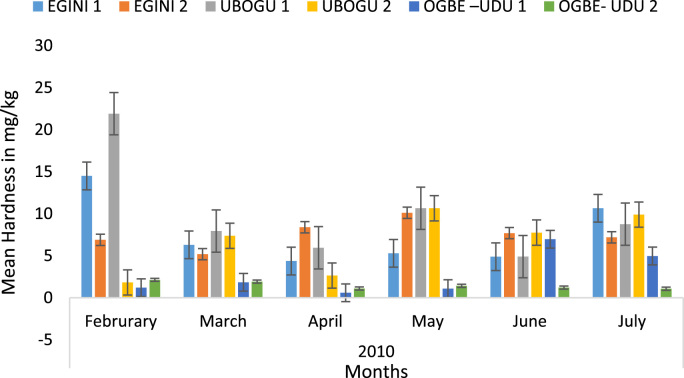
Mean Temporal and spatial variations in hardness.